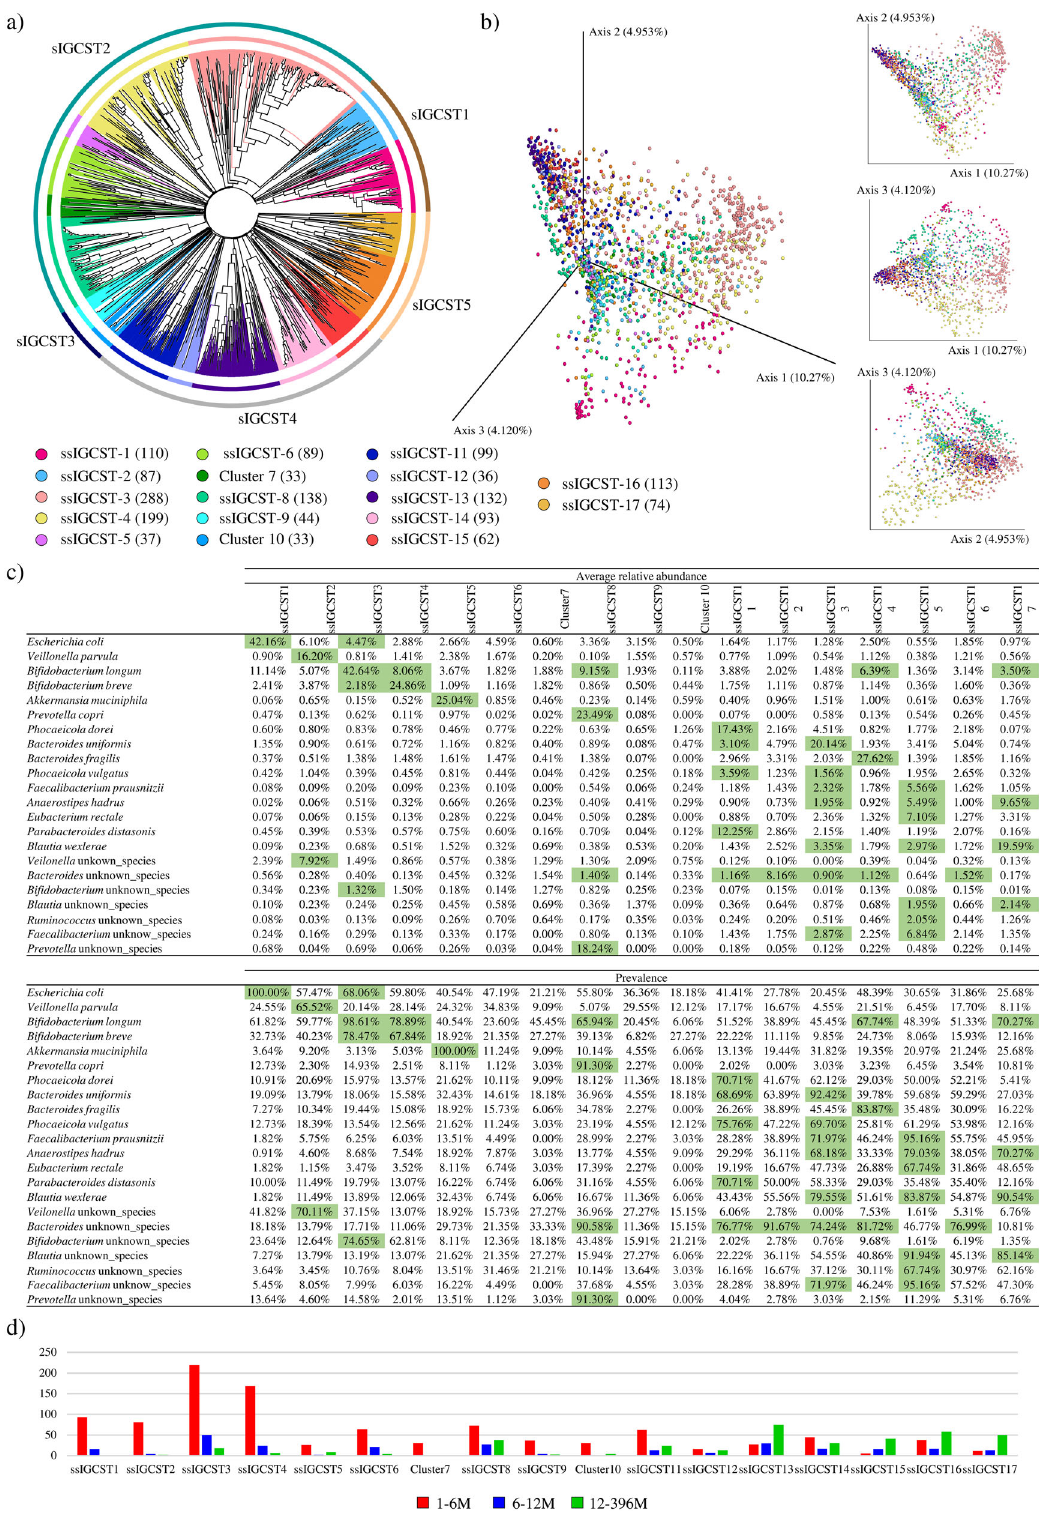
Fig. 2 Identi fi cation of species-level infant gut community state types (sIGCSTs). Panel a reports a circular cladogram generated through a hierarchical clustering (HCL) analysis based on selected publicly available shotgun metagenomes related to fecal samples of healthy infants aged from a few days to three years. The outer circle around the cladogram divides samples according to the identi fi ed sIGCSTs, while the inner circles provide a subdivision of fecal samples based on the de fi ned sub-sIGCSTs. Panel b shows the three- and two-dimensional Principal Coordinate Analysis (PCoA) based on the same samples used for the HCL by coloring samples according to the ssIGCST they belong to. Color legend for panel a and b reports the cluster name and the number of infant fecal samples per each identi fi ed ssIGCST. Panel c displays the average abundance and prevalence of bacteria specifying each identi fi ed ssIGCSTs. Panel d depicts the distribution of samples for each ssIGCST divided by age